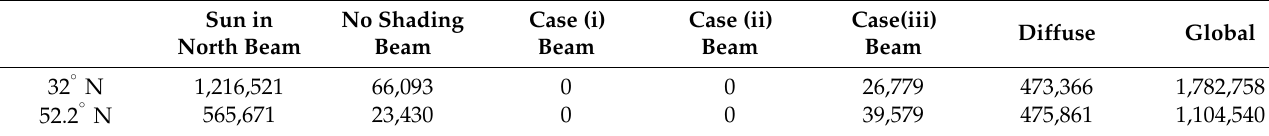
Table 2. South-facing surface: yearly incident irradiation, kWh.